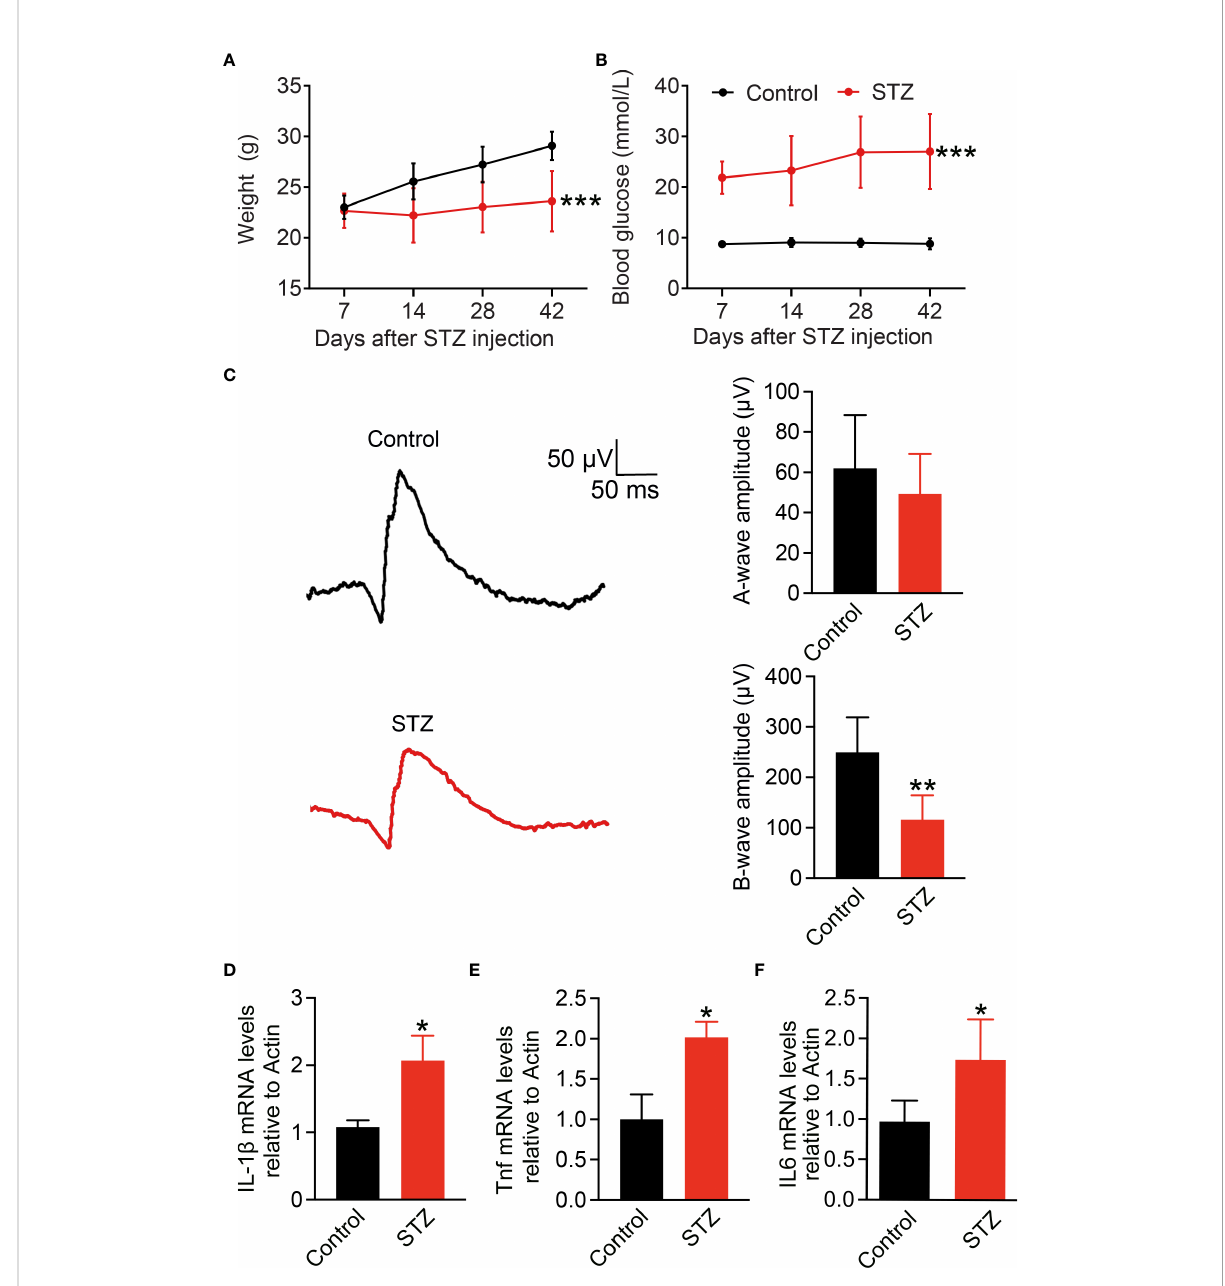
FIGURE 1 Pro-in fl ammatory cytokine IL-1 b increases in STZ-induced diabetic retina. (A,B) Body weight and blood glucose levels were measured weekly after STZ or PBS injection in C57BL/6 male mice (n = 24). (C) Detection of vision functional changes in diabetic retina using representative scotopic ERG. Traces recorded at 4 log cd.s/m 2 fl ash showing mean responses from non-diabetic control (black) and diabetic mice (red). Histograms of a and b waves of all animals studied. (D – F) Retinal IL-1 b , Tnf, and IL6 expressions at mRNA level were detected using RT-PCR (n = 4); *p < 0.05, **p < 0.01 and ***p <